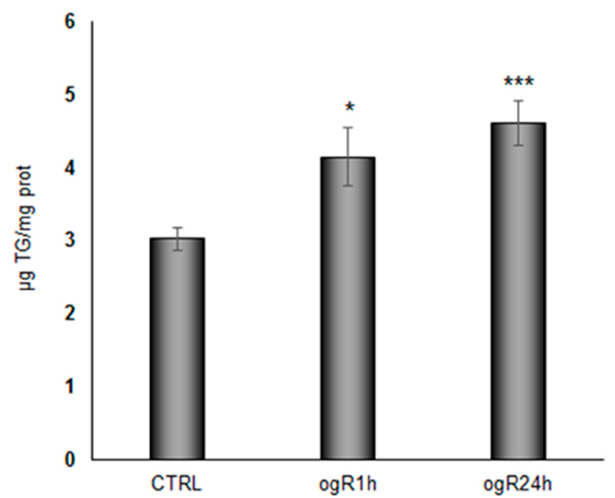
Figure 4. Triglyceride (TG) content in RBE4 after OGD/ogR. Cells, after OGD/ogR treatment, were collected and lipids were extracted by different methanol/chloroform mixtures. TGs were quantified by HPLC-ELSD system. Histogram represents the mean ± S.E. of TG concentration normalized to protein content in the same sample. * p < 0.05, *** p < 0.001 vs. control, n = 3.